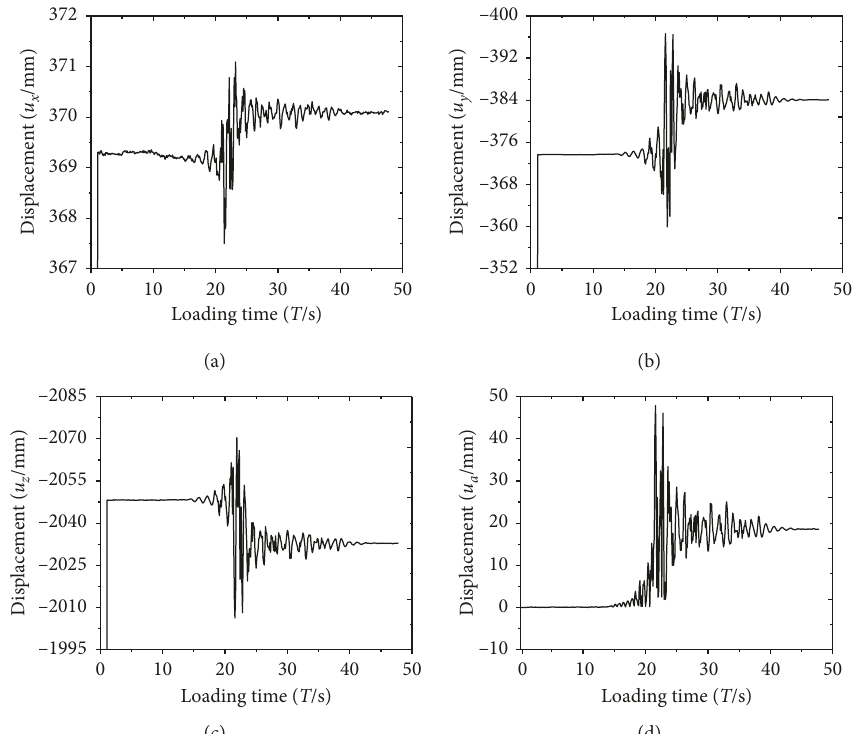
Figure 16: Variation of displacement with loading time.